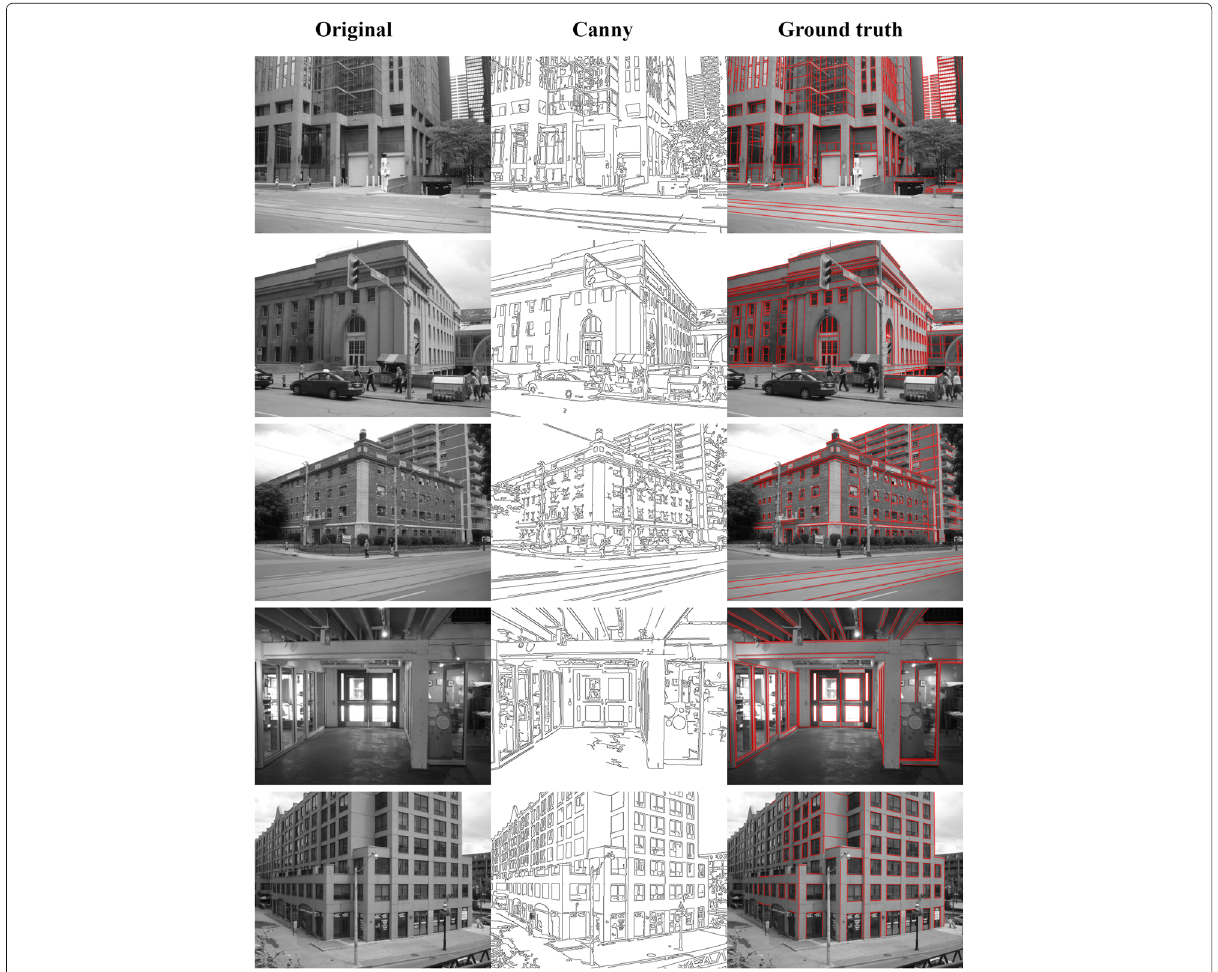
Fig. 12 Second set of images used for the detection of endpoints, corners, and line